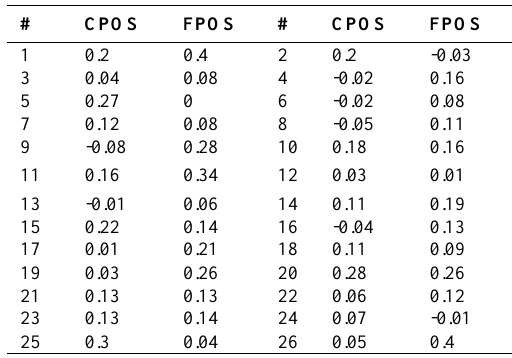
Table 7. Added features effect on increase and decrease of accuracy for